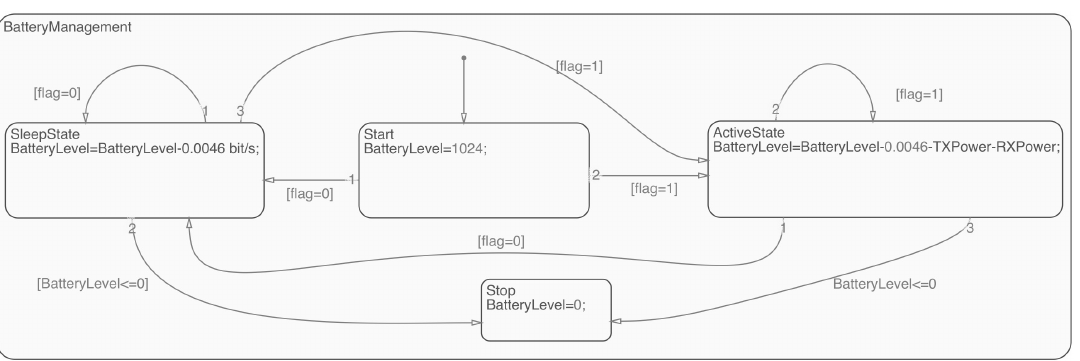
Figure 6. Battery consumption flow chart created in